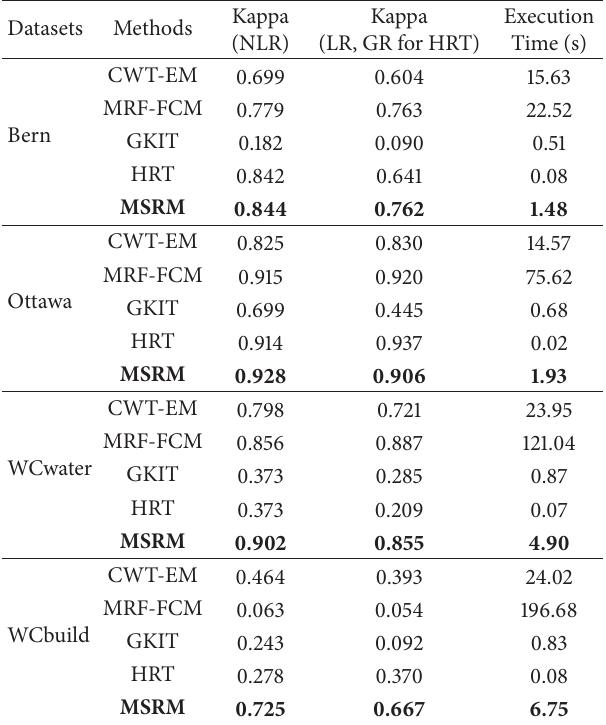
Table 1: Kappa coefficient and execution time.